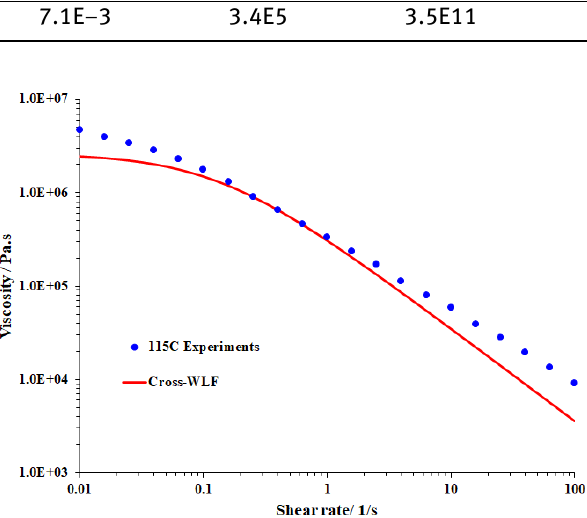
Figure 3: Viscosity as a function of shear rate for different nonlinear parameters α with T = 120 ∘ C, λ = 8.7 s and η = 6.2 E + 6 Pa · s